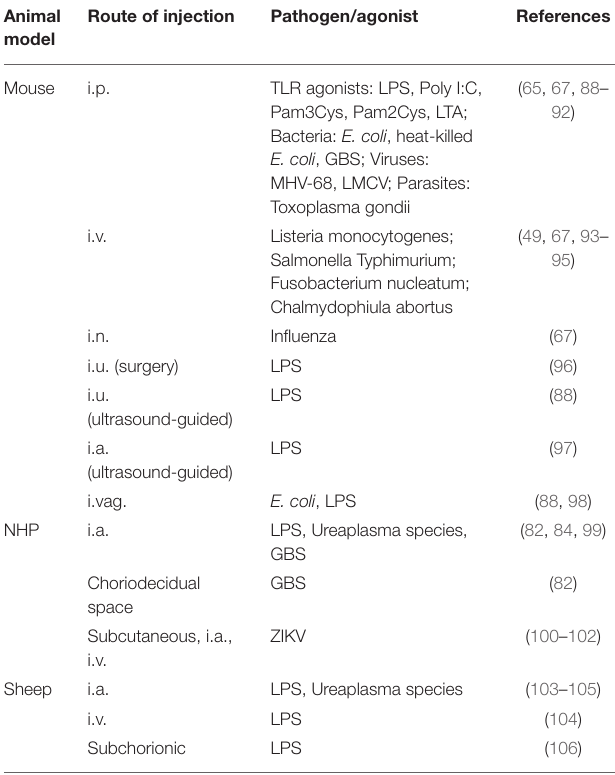
TABLE 1 | Animal models for